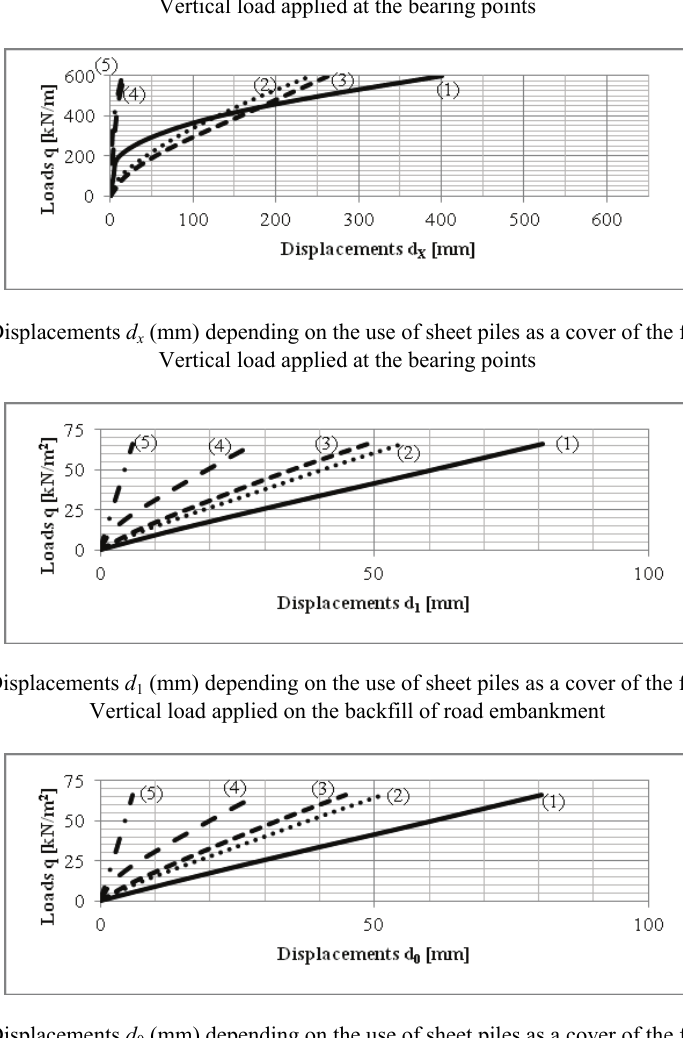
Fig. 5b. Displacements d 0 (mm) depending on the use of sheet piles as a cover of the foundation. Vertical load applied on the backfill of road